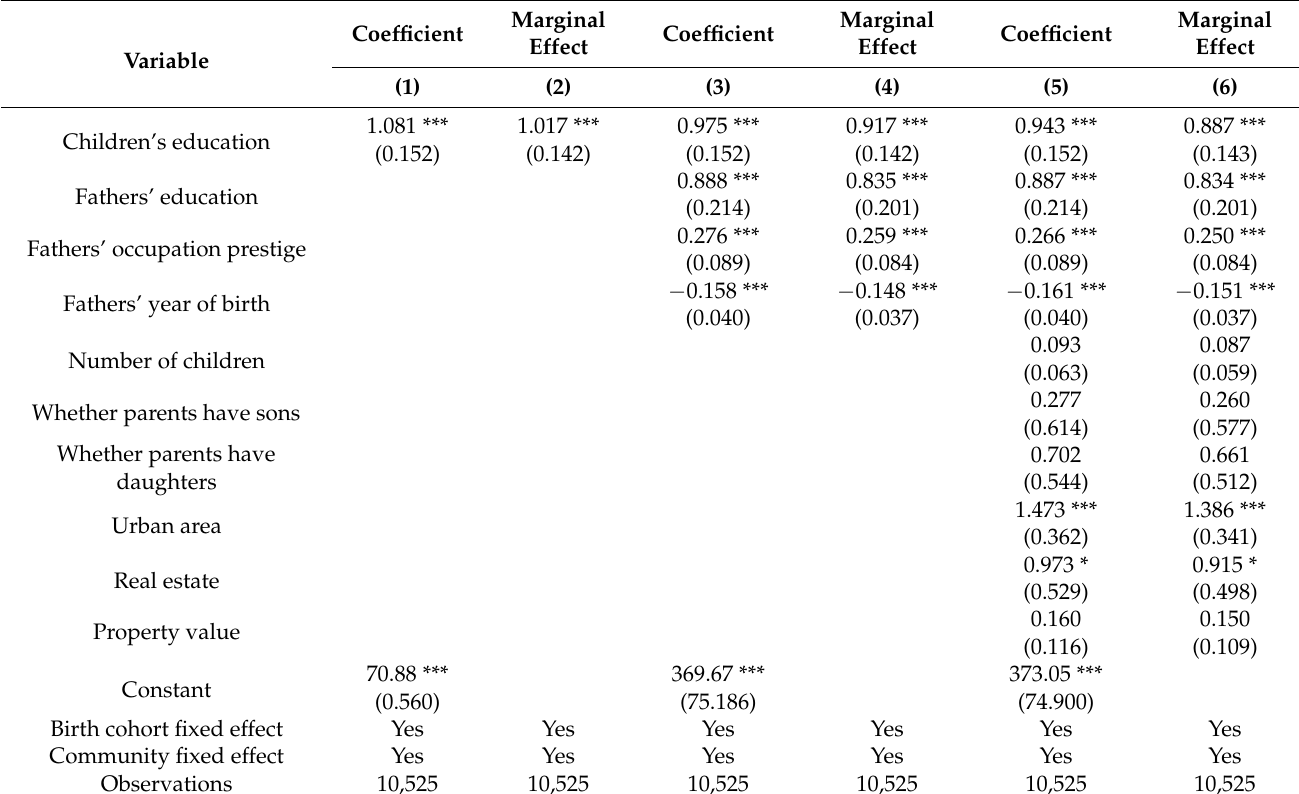
Table 2. Estimation results of adult children’s education on fathers’